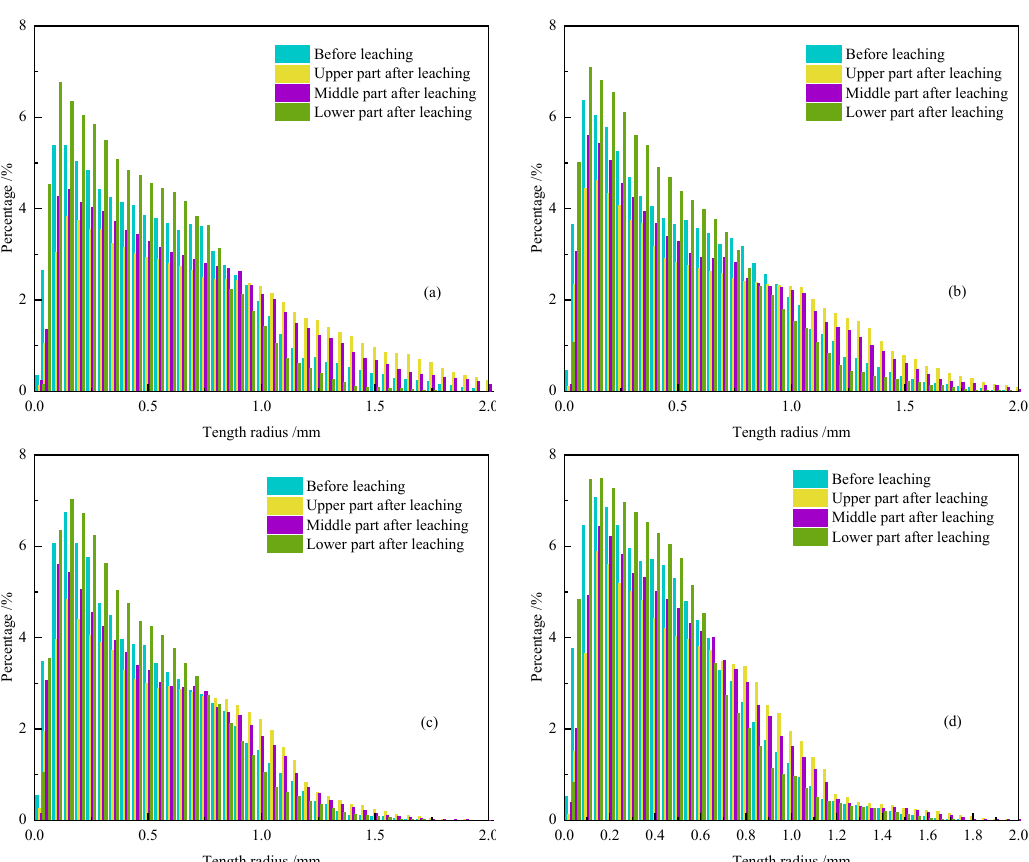
Figure 13. Distribution curves of the pore throat radius. ( a ) A D = 2 . 03 ; ( b ) B D = 2 . 23 ; ( c ) C D = 2 . 43 ; ( d ) D D = 2 . 63 .